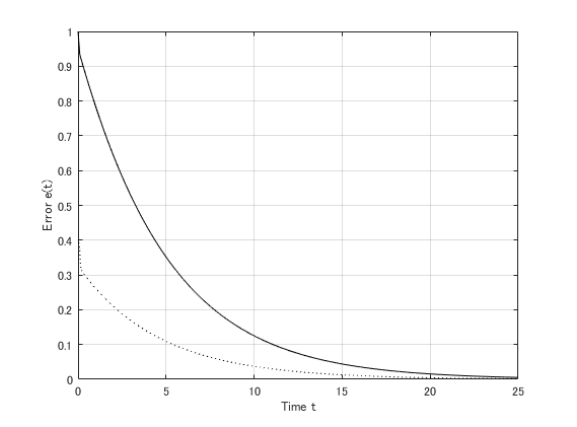
Figure 2. The error